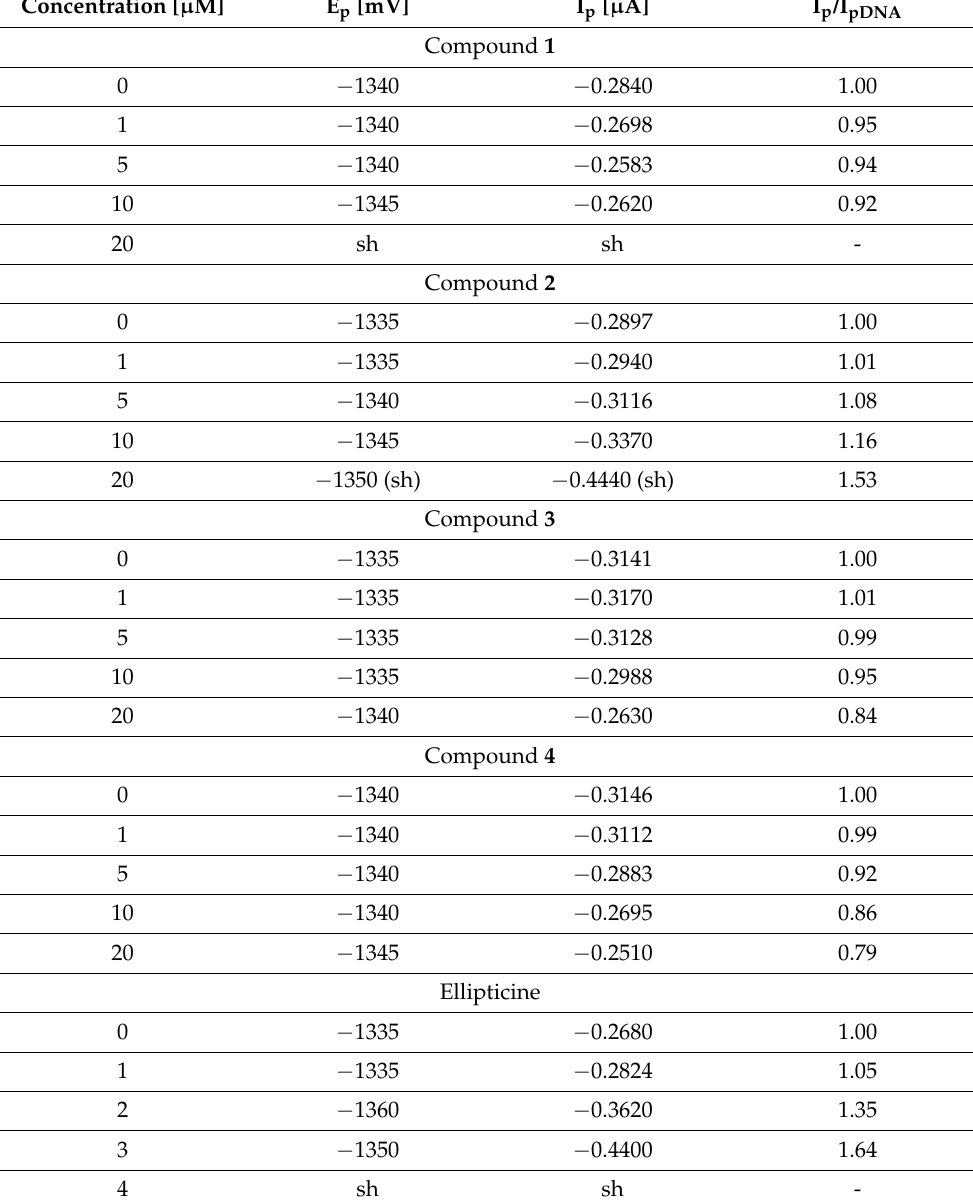
Table 1. Electrochemical data of DNA reduction peak according to the compounds’